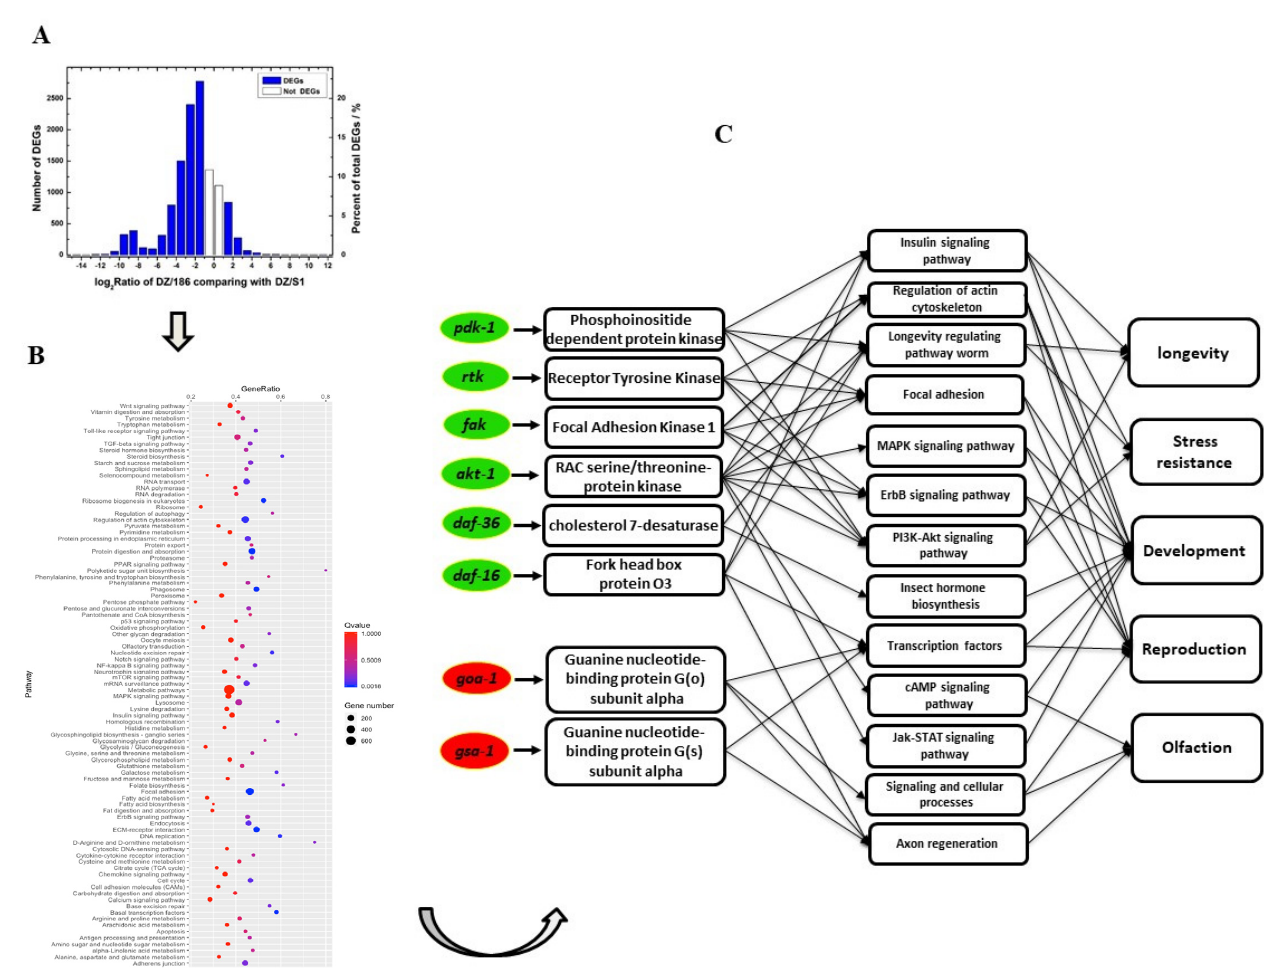
Figure 2. ( A ) Global comparison analysis of expression level of all mRNA data of native vs. non- native monoxenic O. chongmingensi . ( B ) The top 100 signaling pathways enriched in DEGs an- notated by KEGG analysis. ( C ) Predicted functions of six downregulated and two upregulated DEGs in DZ/186 involved in regulating longevity, stress resistance, and chemotaxis, according to previous studies.